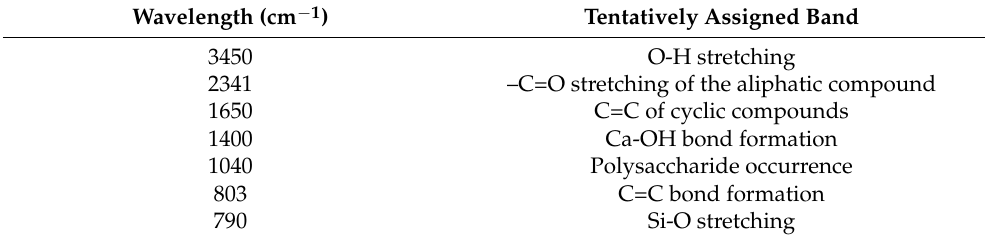
Figure 7. FTIR analysis of the untreated peat and treated peat with OPC, SF, and OPC + SF. Table 5. Tentative band assignment for IR spectra of parent and stabilized peat.